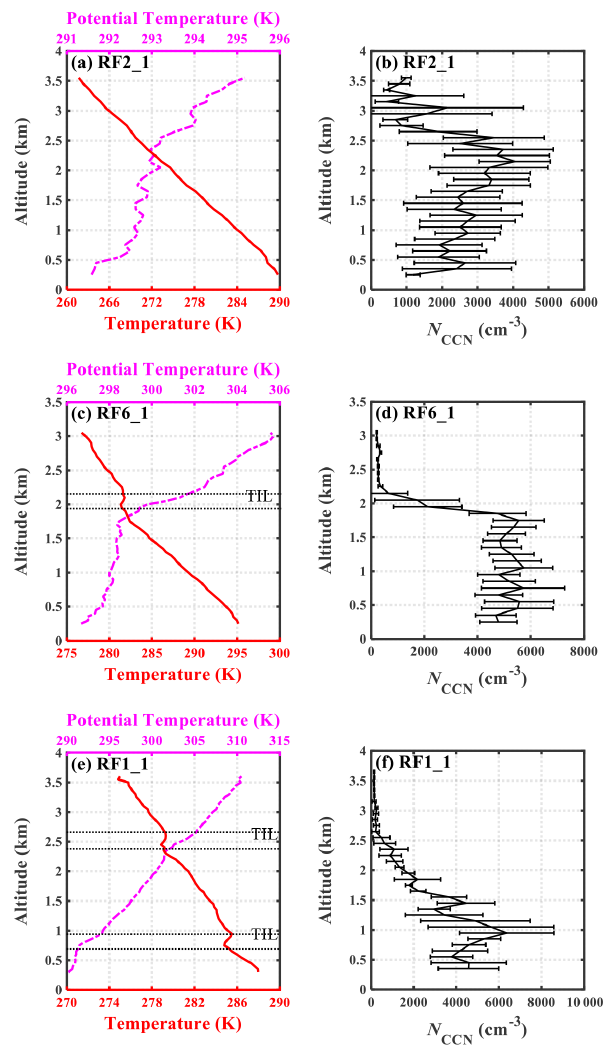
Figure 3. Vertical distributions of temperature ( T ) and potential temperature ( θ ) (a, c, e) , and N CCN at 0.7% SS (b, d, f) for RF2_1, RF6_1, and RF1_1 N CCN profiles with (from top to bottom) no temperature inversion layer (TIL), one TIL, and two TILs. T and θ are averaged in the intervals of 50m in altitude. Horizontal error bars of N CCN represent standard deviations of N CCN at 0.7% SS at altitude intervals of 100m.